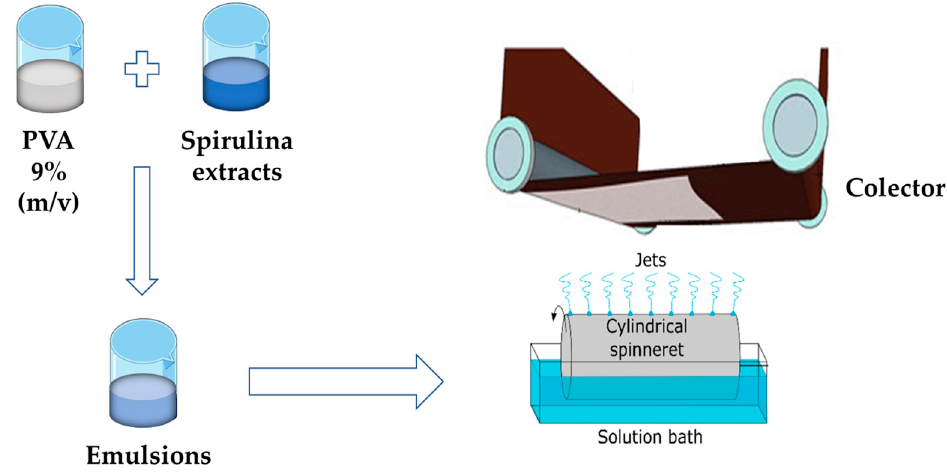
Figure 1. Electrospinning